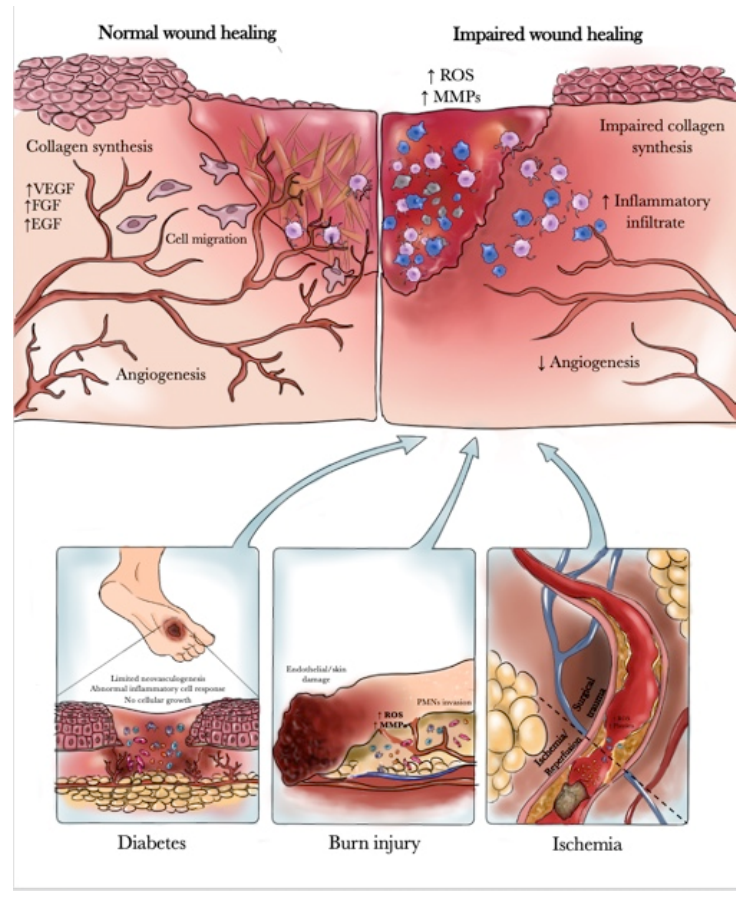
Figure 1. Molecular mechanism in Impaired wound healing. Polydeoxyribonucleotide